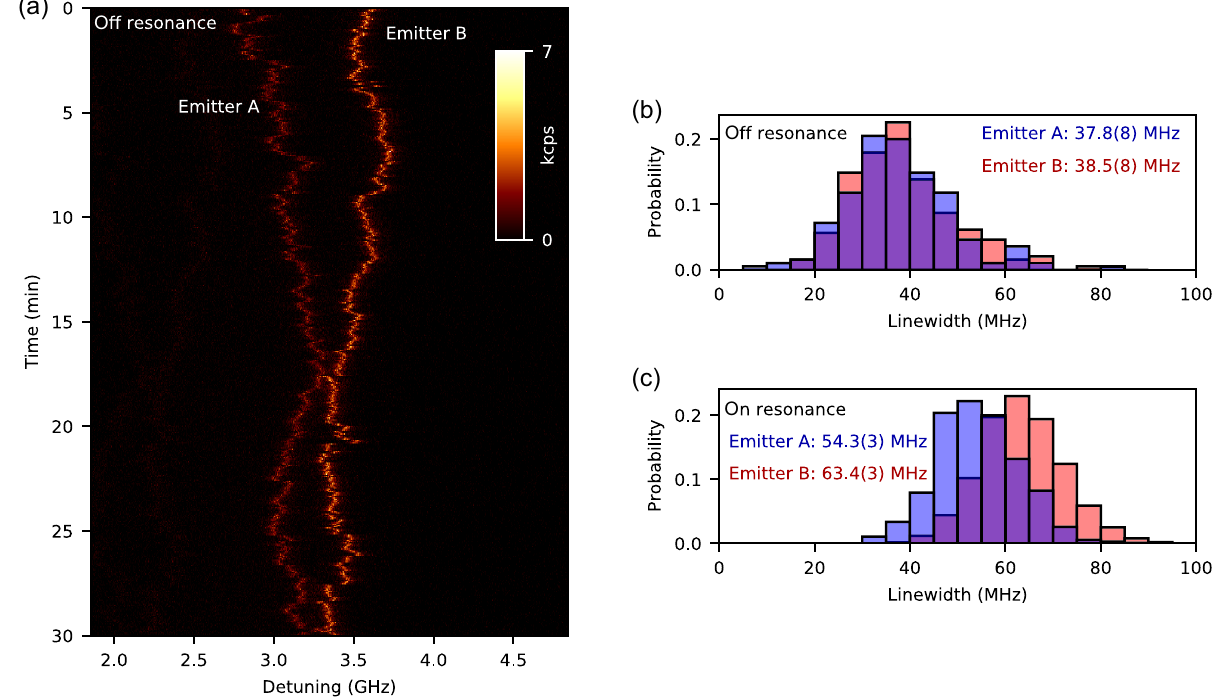
FIG. 9. Emitter linewidths on and off resonance with the cavity. (a) A continuous PLE scan of the two emitters with the cavity far detuned. (b) A histogram of fitted single-scan linewidths. Indicated in the figure is the mean fitted linewidth and its standard error. (c) Histogram of time-averaged scans for PLE data presented in Fig. 1(d) of the main text, showing spectral broadening caused by lifetime reduction of the optical transition. Emitter B transition is broader due to the stronger Purcell